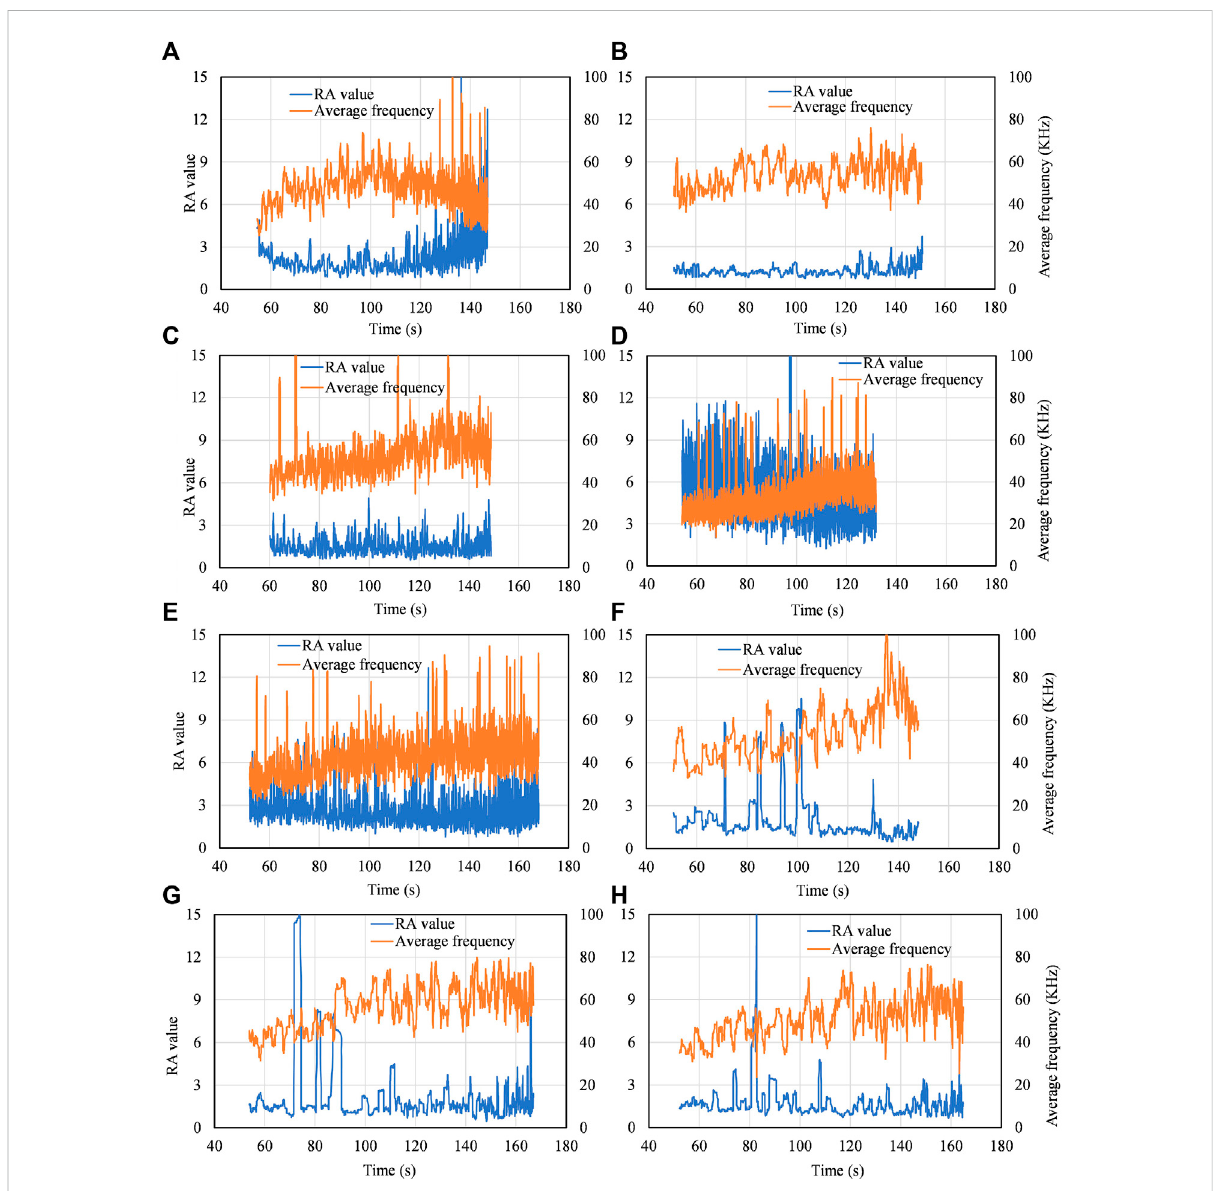
FIGURE 16 FluctuationsofRAvaluesandAvrfrequenciesinuncoatedcase, (A) Healthyconditioninuncoatedcase. (B) Initiationstageinuncoatedcase. (C) Accelerationstageinuncoatedcase. (D) Deteriorationstageinuncoatedcase. (E) Healthyconditionincoatedcase. (F) Initiationstageincoatedcase. (G) Acceleration stage in coated case. (H) Deterioration stage in coated